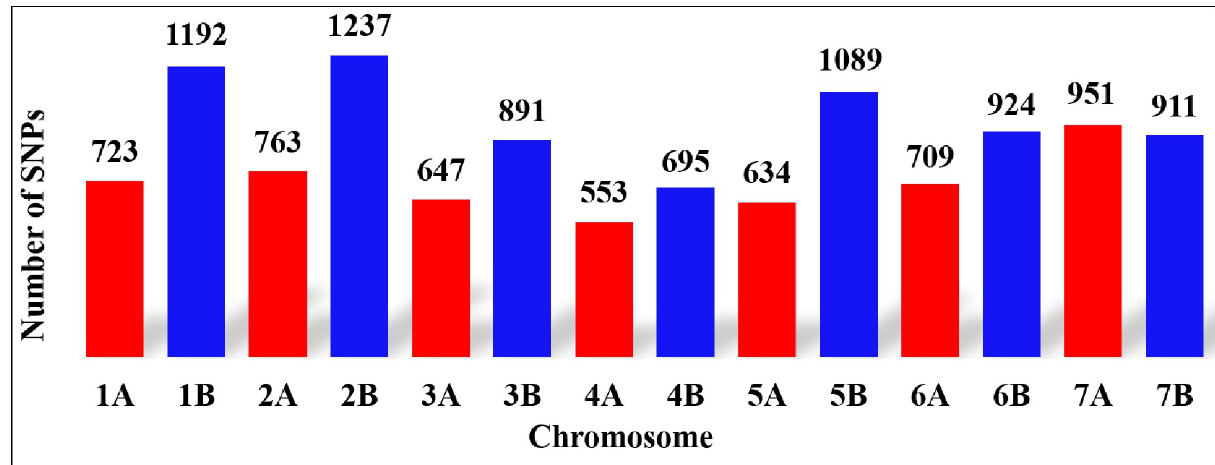
Fig 2. Distribution of 11,919 filtered Single nucleotide polymorphisms (SNPs) across the durum wheat genome. Genome A and B are marked with red and blue colors, respectively.